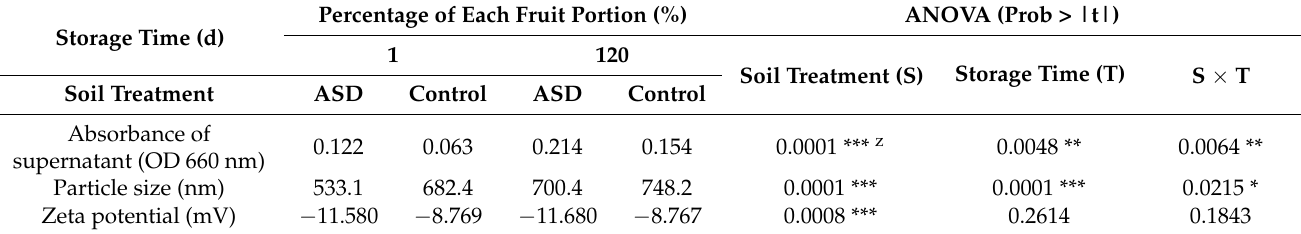
Table 2. Effect of soil treatment and storage time on particle size and juice stability of winter melon juice